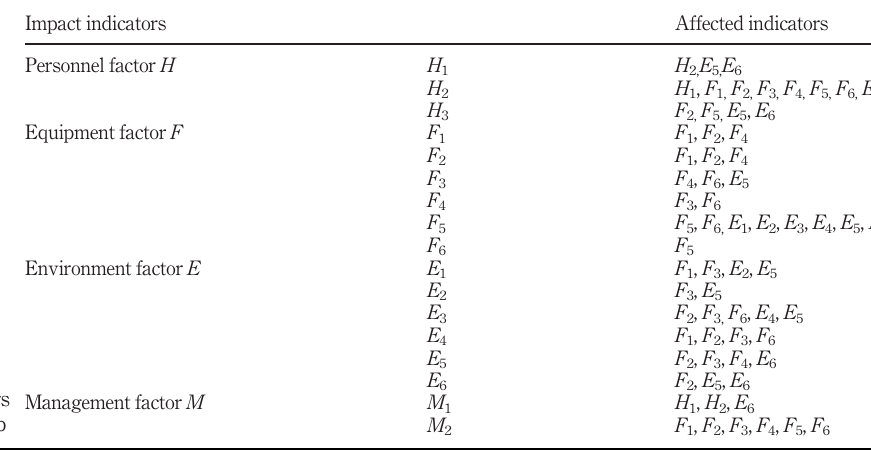
Table 1. Evaluation indicators coupling